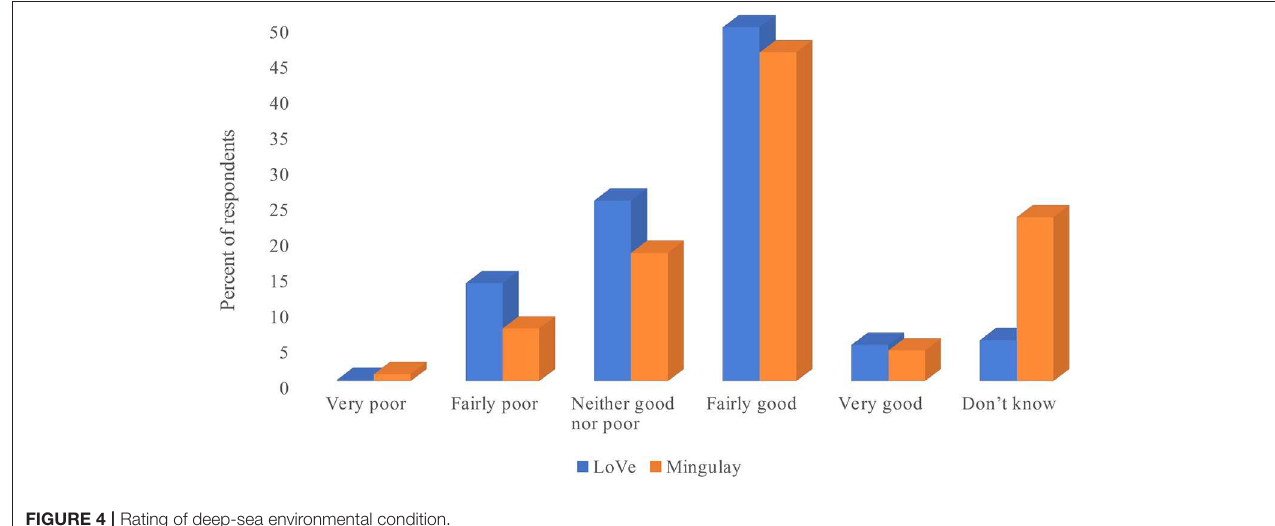
FIGURE 4 | Rating of deep-sea environmental condition.